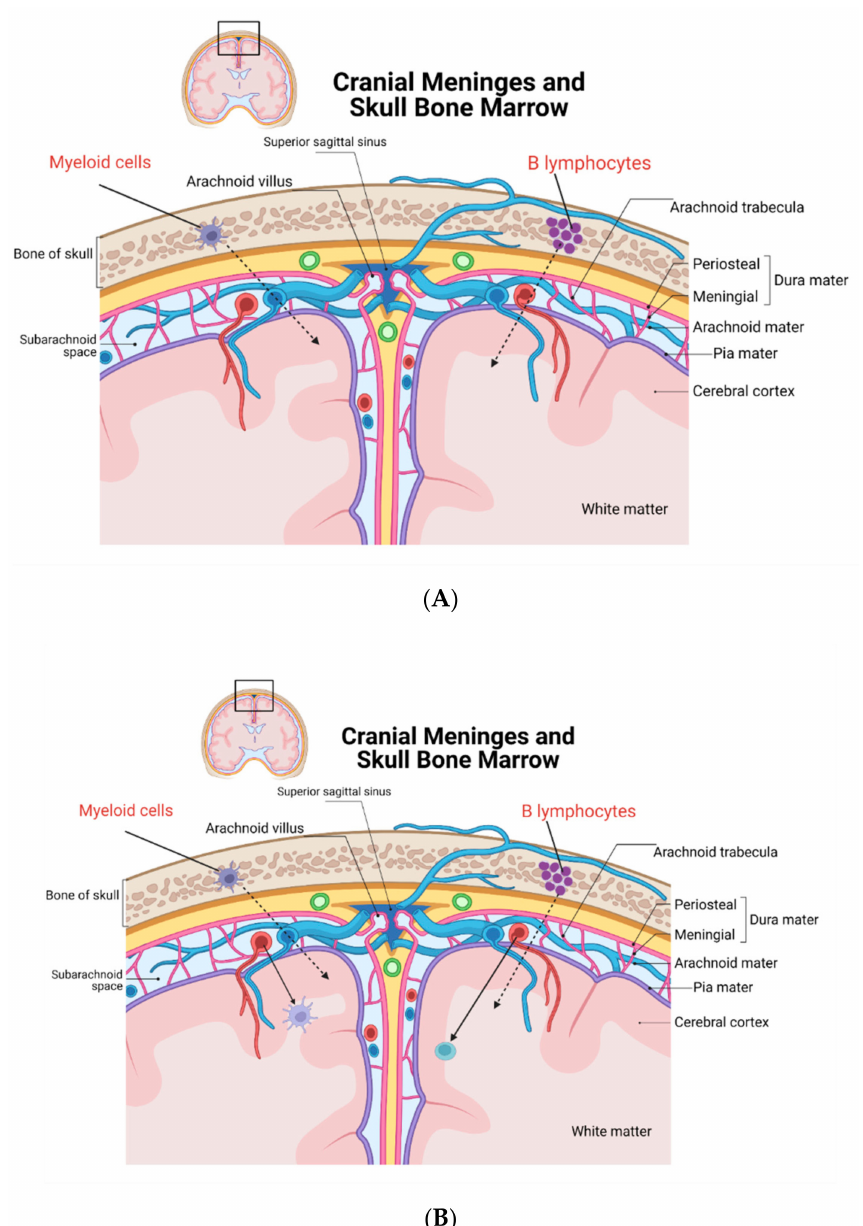
Figure 1. New concepts in the topographical organization of the immune response in CNS. ( A ) Myeloid cells and B lymphocytes normally patrolling the CNS are derived from the skull bone marrow (red characters) and are able to migrate to meninges and to cerebral tissue by travelling through small skull bone vascular channels (not depicted for figure clarity, represented here by dashed arrow lines). ( B ) Ageing and CNS pathologies could increase tissue infiltration by myeloid cells and B cells from the general blood circulation (represented by the solid arrow lines), altering the local “milieu” and favouring local immune dysfunction, autoimmunity, and altered repair mechanisms (see main text and related references for more